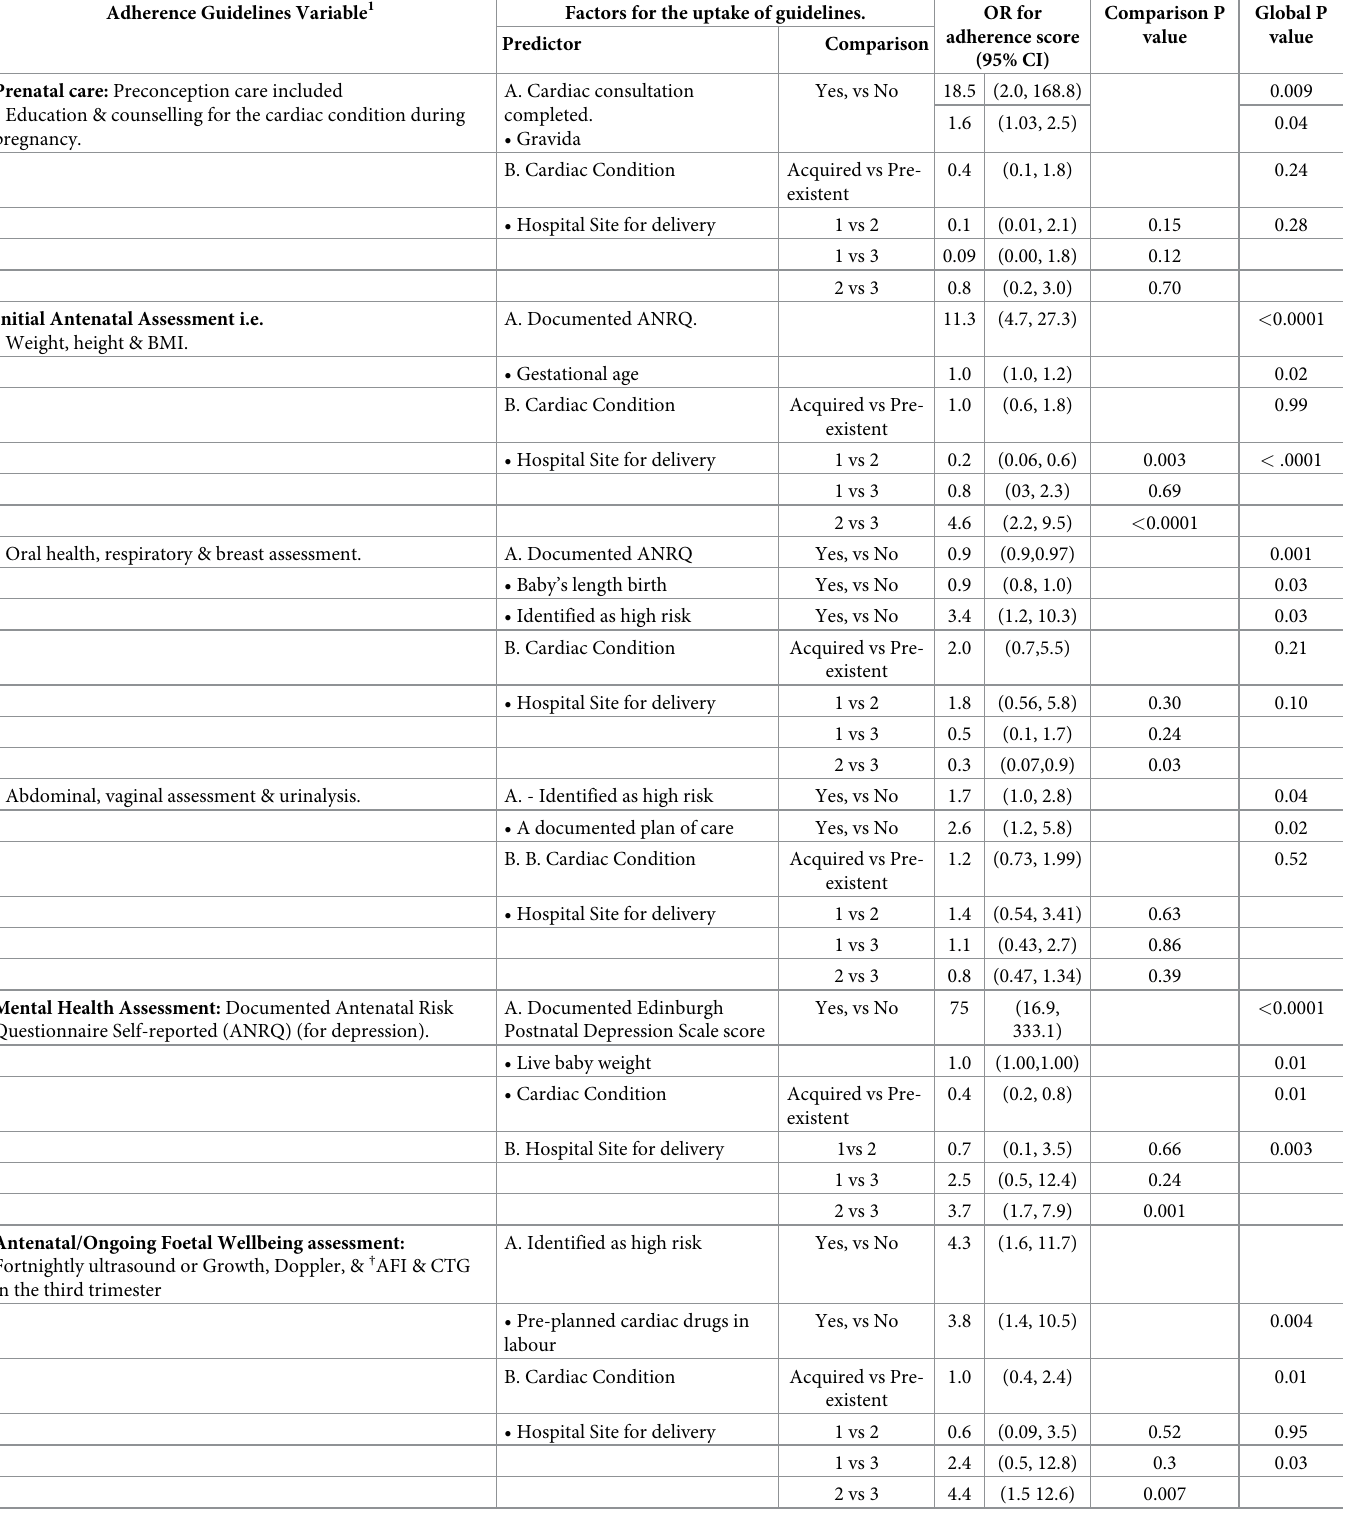
Table 3. Significant factors that influenced the adherence score for the guidelines for cardiac disease in pregnancy across three public hospitals (2003–2013). Adherence Guidelines Variable 1 Factors for the uptake of